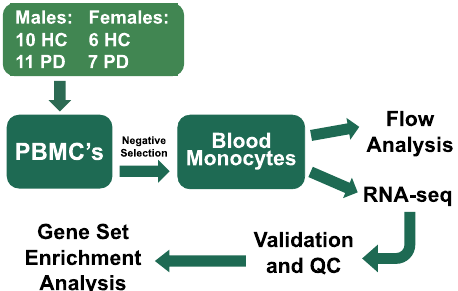
Fig. 8 Overview of methods. Peripheral blood mononuclear cells (PBMCs) from healthy control (HC) subjects and Parkinson Disease (PD) subjects were collected. Monocytes were then isolated using negative selection. Flow analysis was conducted, and RNA was isolated for RNA-seq analysis and qRT-PCR. The resulting data were analyzed for differences between PD and HC